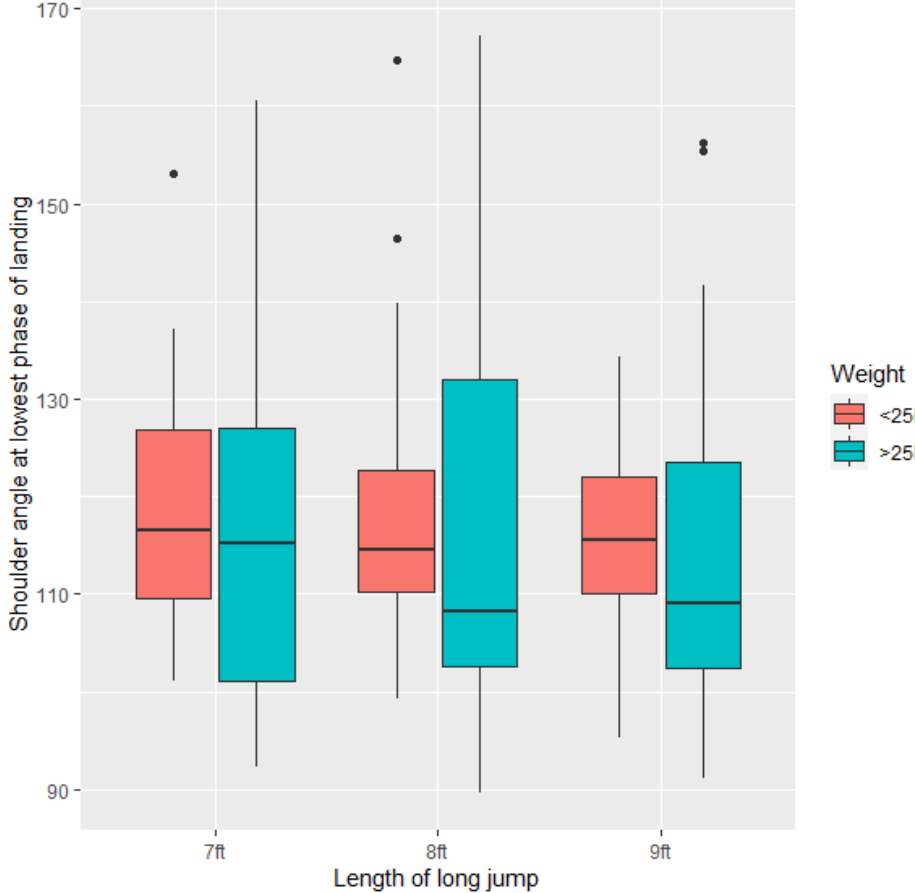
Figure 9. Apparent shoulder angle (degrees) at the lowest phase of landing across all the study dogs ( n = 21) at the three long jump lengths (7 ft, 8 ft, 9 ft).